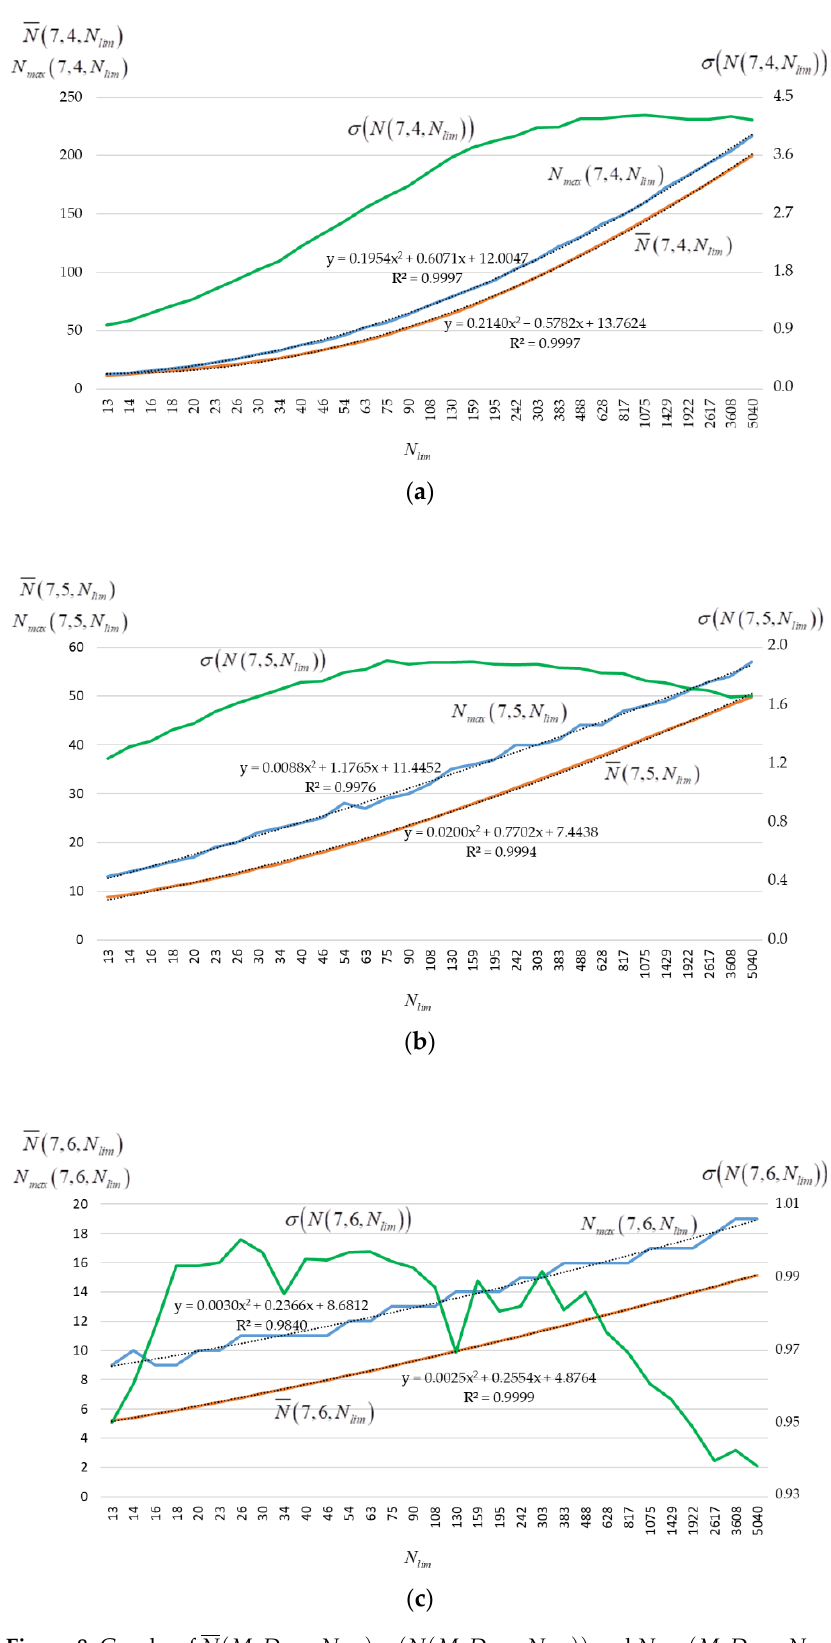
Figure 8. Graphs of N ( M , D min , N lim ) , σ ( N ( M , D min , N lim )) and N max ( M , D min , N lim ) for M = 7